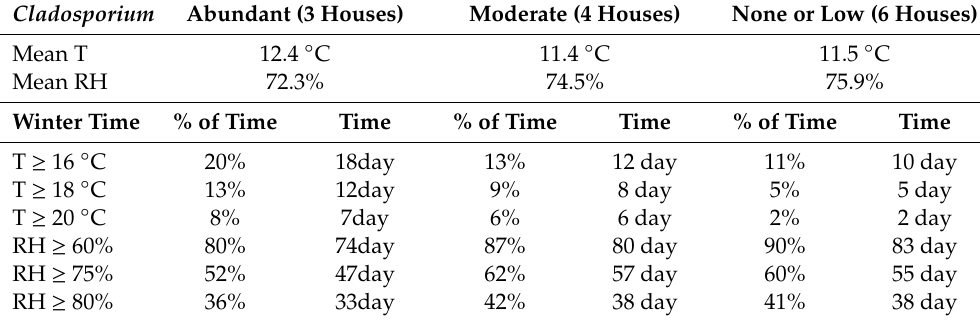
Table 5. Winter indoor microclimatic conditions of the 13 sample houses with di ff erent growth levels of Cladosporium .